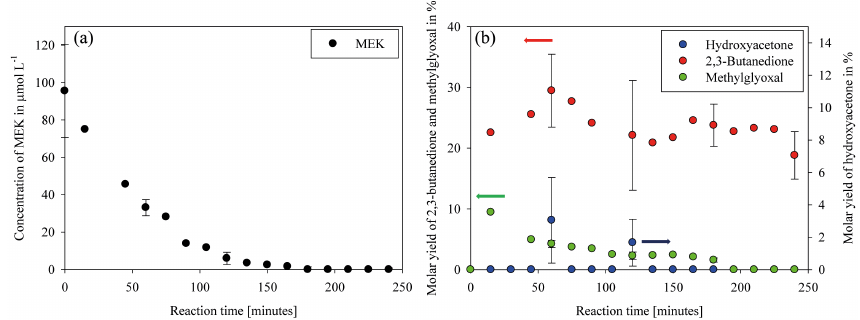
Figure 1. (a) Consumption of MEK during the oxidation with OH radicals and (b) time-resolved formation of the products methylglyoxal, 2,3-butanedione, and